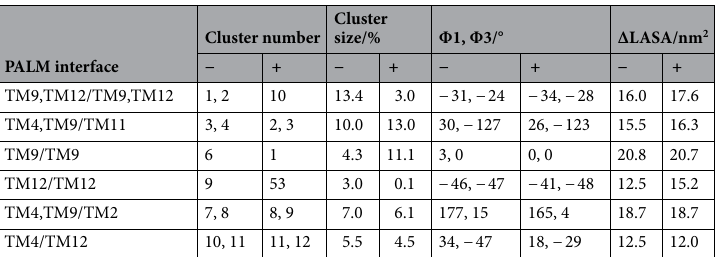
Table 1. hDAT and hDAT-palm cluster properties. The cluster number and cluster size for the different dimers is given for the system with ( +) and the system without (−) palm. The dimers relative orientation is given by the 1 and 3 angle (see Fig. 2a) and the average ΔLASA for the different dimer interfaces is listed. Notice that some clusters come in pairs e.g. cluster 7,8 due to symmetry considerations, which is elaborated ϕ ϕ upon in the Methods section under